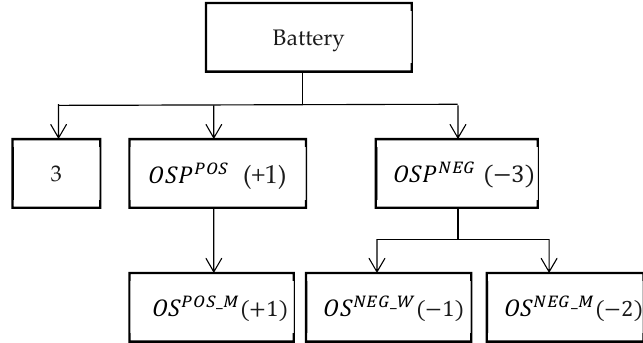
Figure 5. Feature Figure 5. Feature tuple.